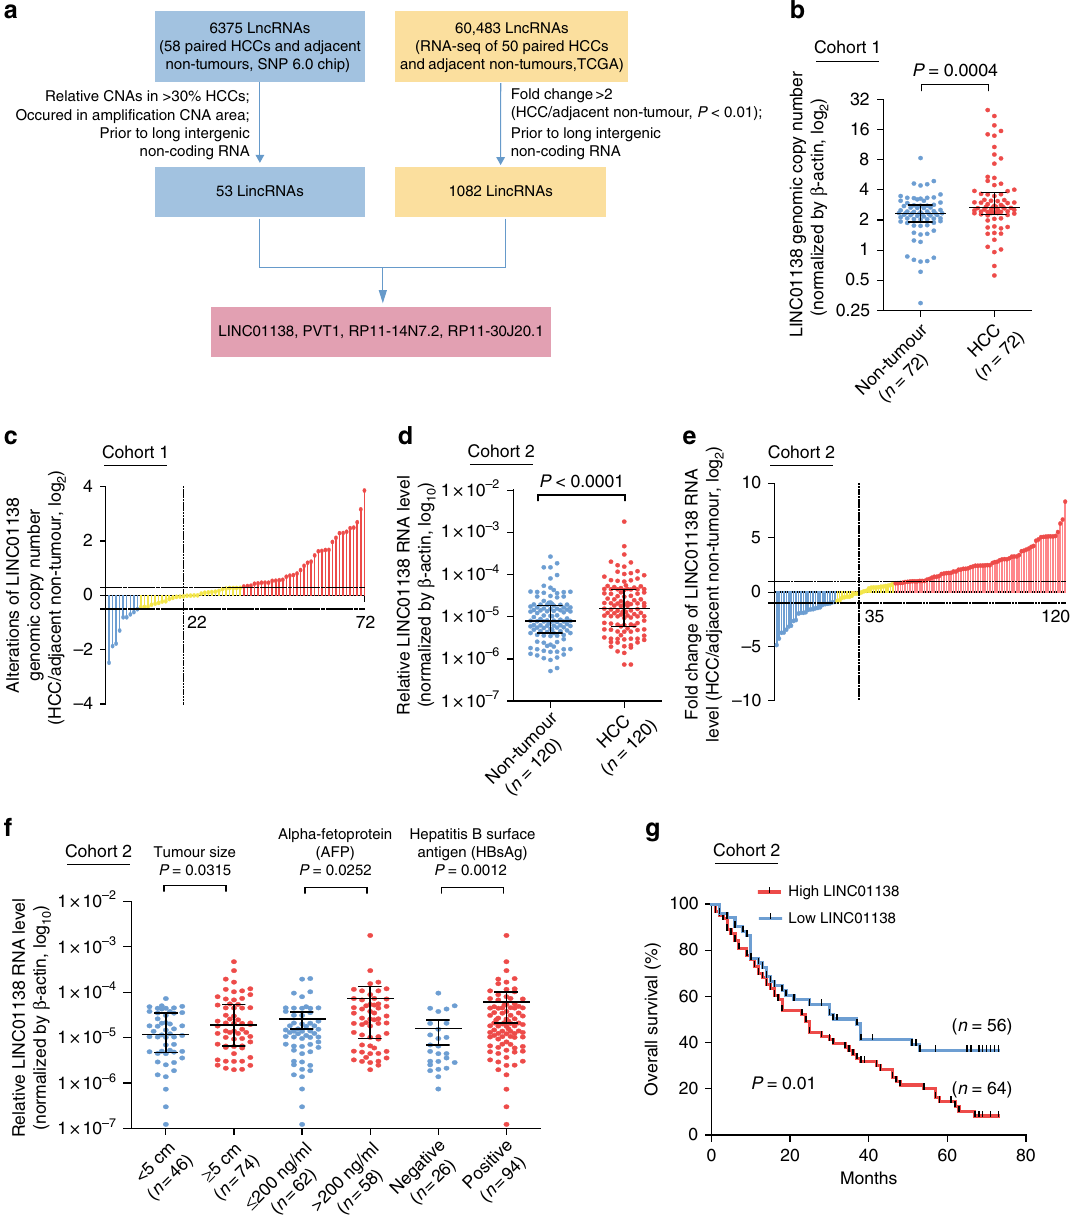
Fig. 1 LINC01138 is associated with clinical outcomes in patients with HCC. a The fl ow chart for selecting candidate lincRNAs in HCC; four lincRNAs were identi fi ed for further study. b The copy numbers of LINC01138 were determined in 72 pairs of HCC tissues and adjacent normal tissues using qPCR. c Fold- change of LINC01138 copy number variations in 72 paired tissues (deletion, blue; no-change, yellow; ampli fi cation, red.). d The RNA levels of LINC01138 were quanti fi ed in 120 pairs of HCC tissues and adjacent normal tissues using qPCR. e Fold-changes of expression of LINC01138 in 120 paired tissues (downexpression, blue; no-change, yellow; upexpression, red.). f Clinical signi fi cance of LINC01138 in patients with HCC; high LINC01138 expression positively correlated with tumour size ( ≥ 5 cm), AFP (>200 ng/ml) and HBsAg-positive patients. g Kaplan – Meier analyses of the correlation between LINC01138 RNA levels and the overall survival in 120 patients with HCC. Patients were strati fi ed for the analysis by the median value. Values are expressed as the median with interquartile range in b , d ,